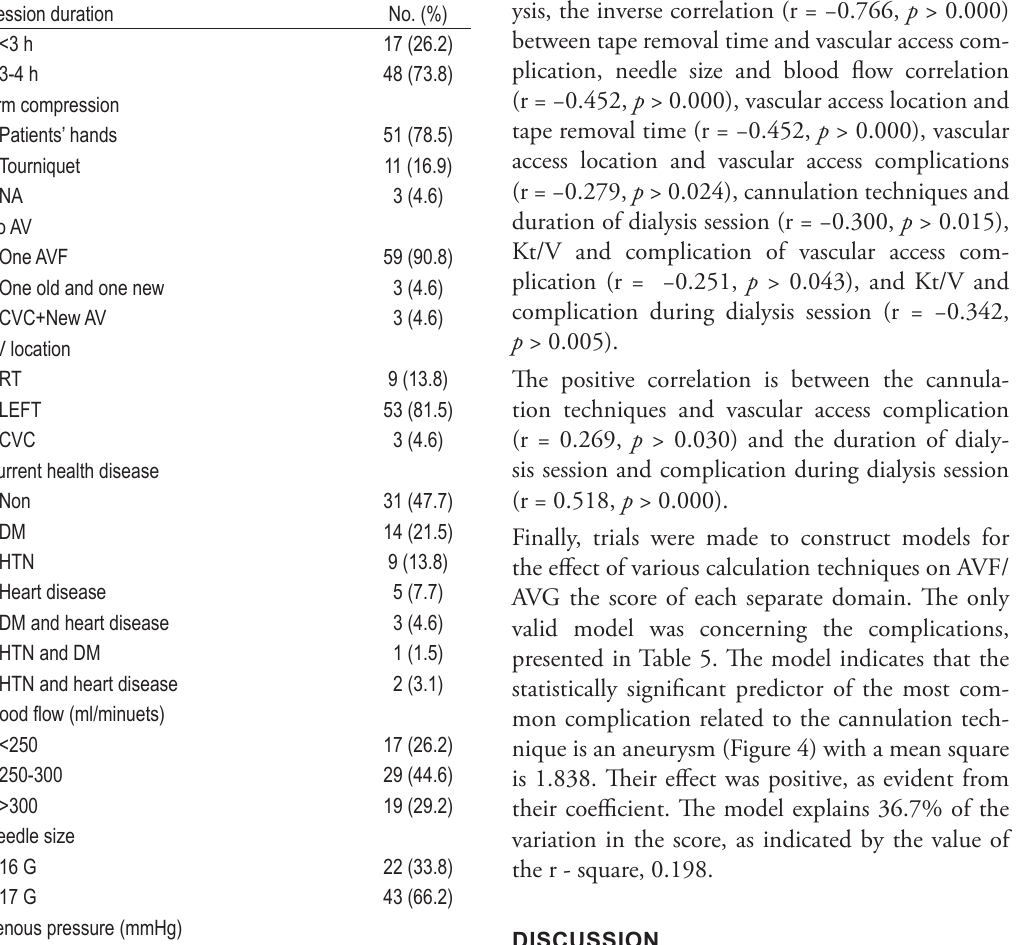
TABLE 3. Hemodialysis session characteristics of patients in the study sample